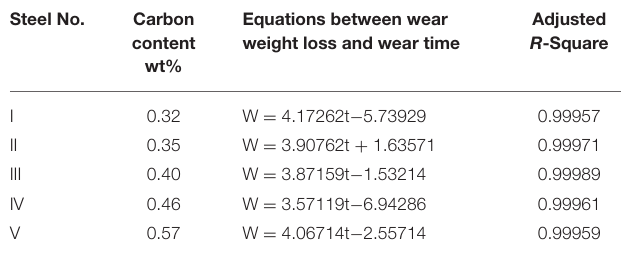
TABLE 3 | Equations modeling correlation between weight loss and wear time. Steel